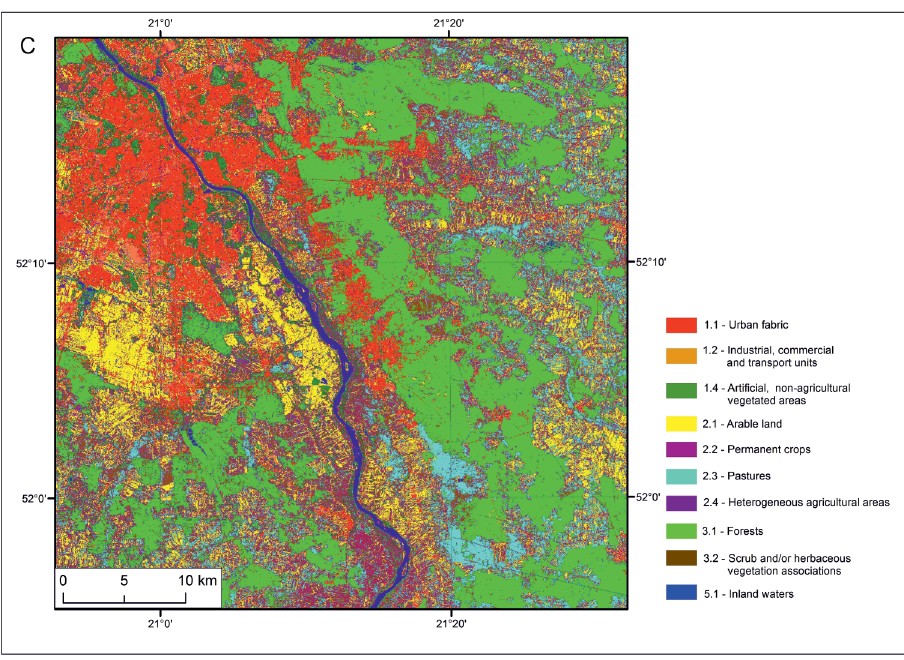
Fig. 3. Classification map of the image acquired on: A – 21.04.2011, B – 05.06.2010, C –